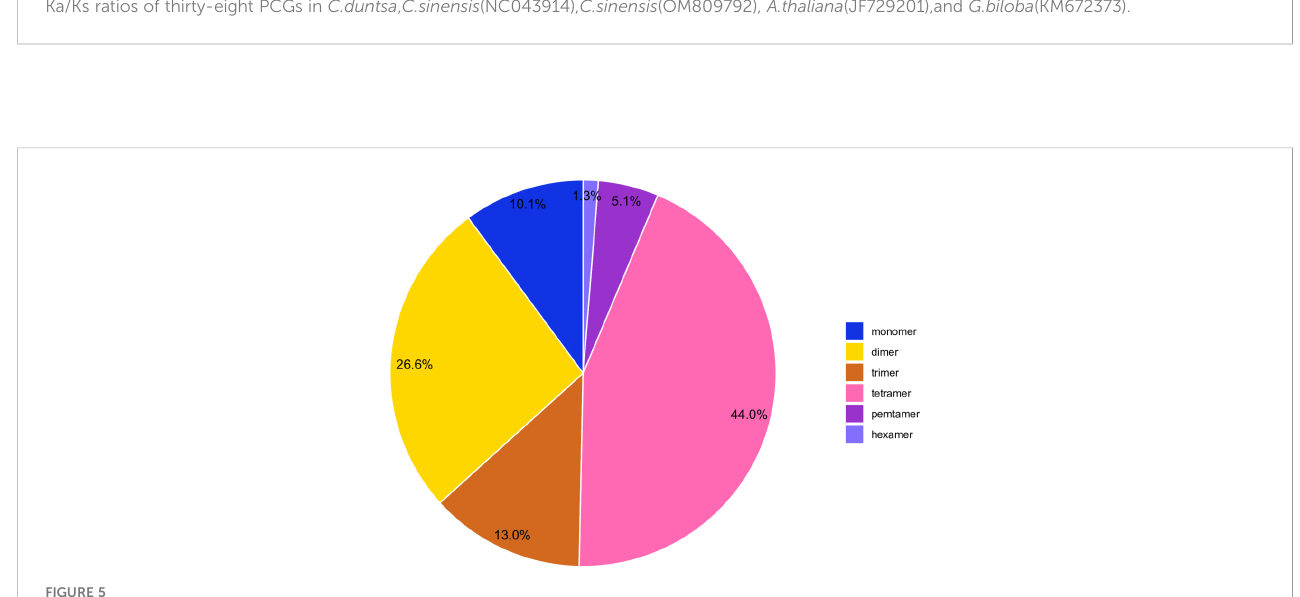
FIGURE 5 C .duntsa SSR distribution. Different hues denote SSRs. The graphic shows SSR percentages.